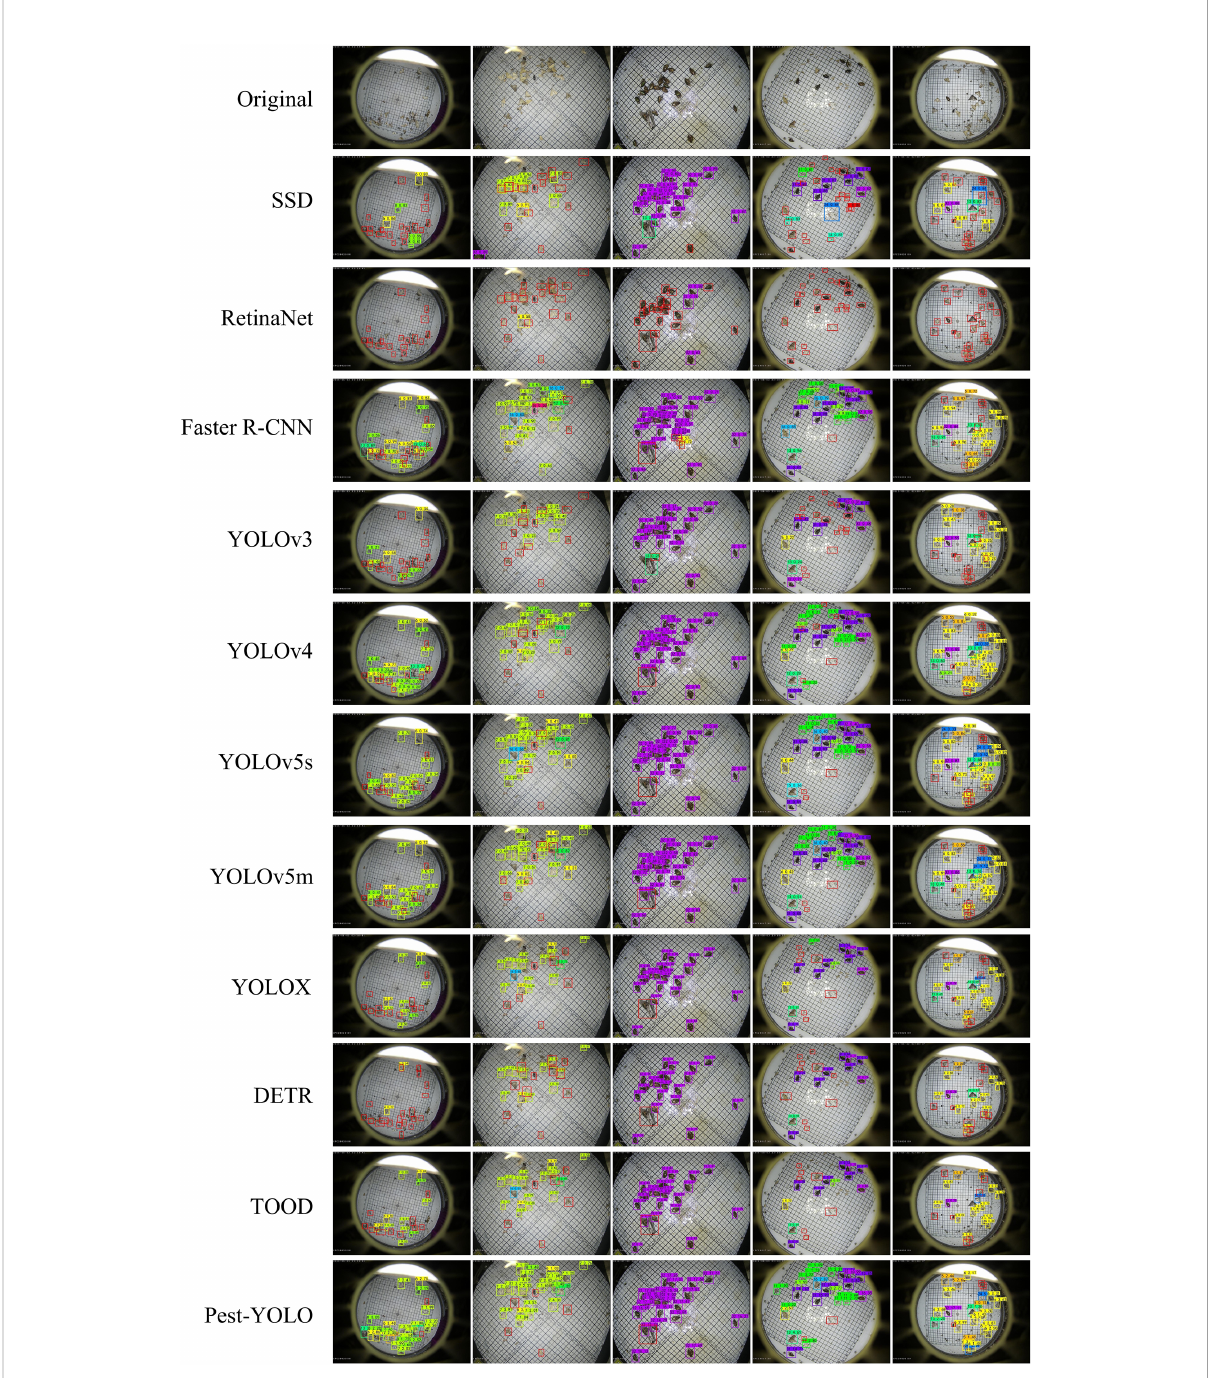
FIGURE 7 Illustration of the detection results of different detectors. Red boxes represent pests missed by a